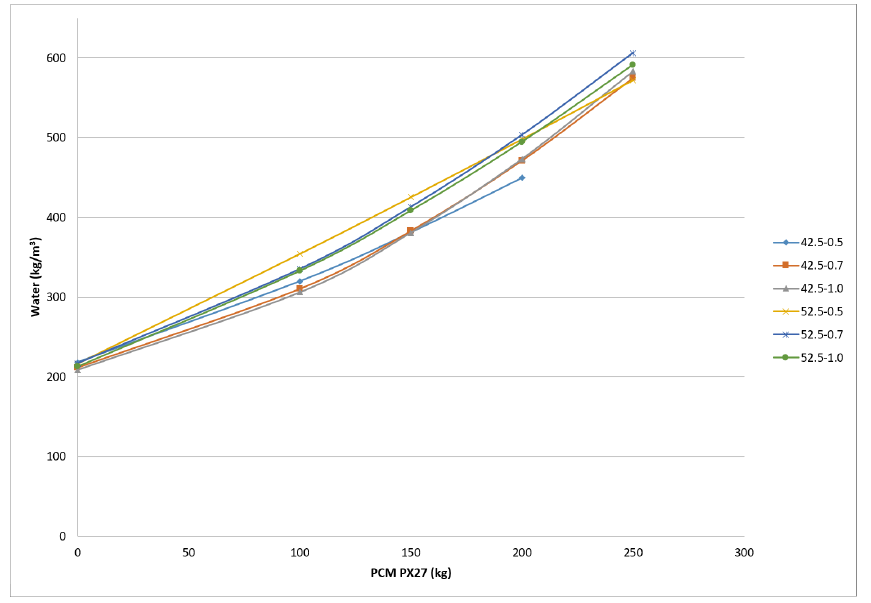
Figure 7. Water content for mixtures with different PCM PX 27 content, cements and w/c